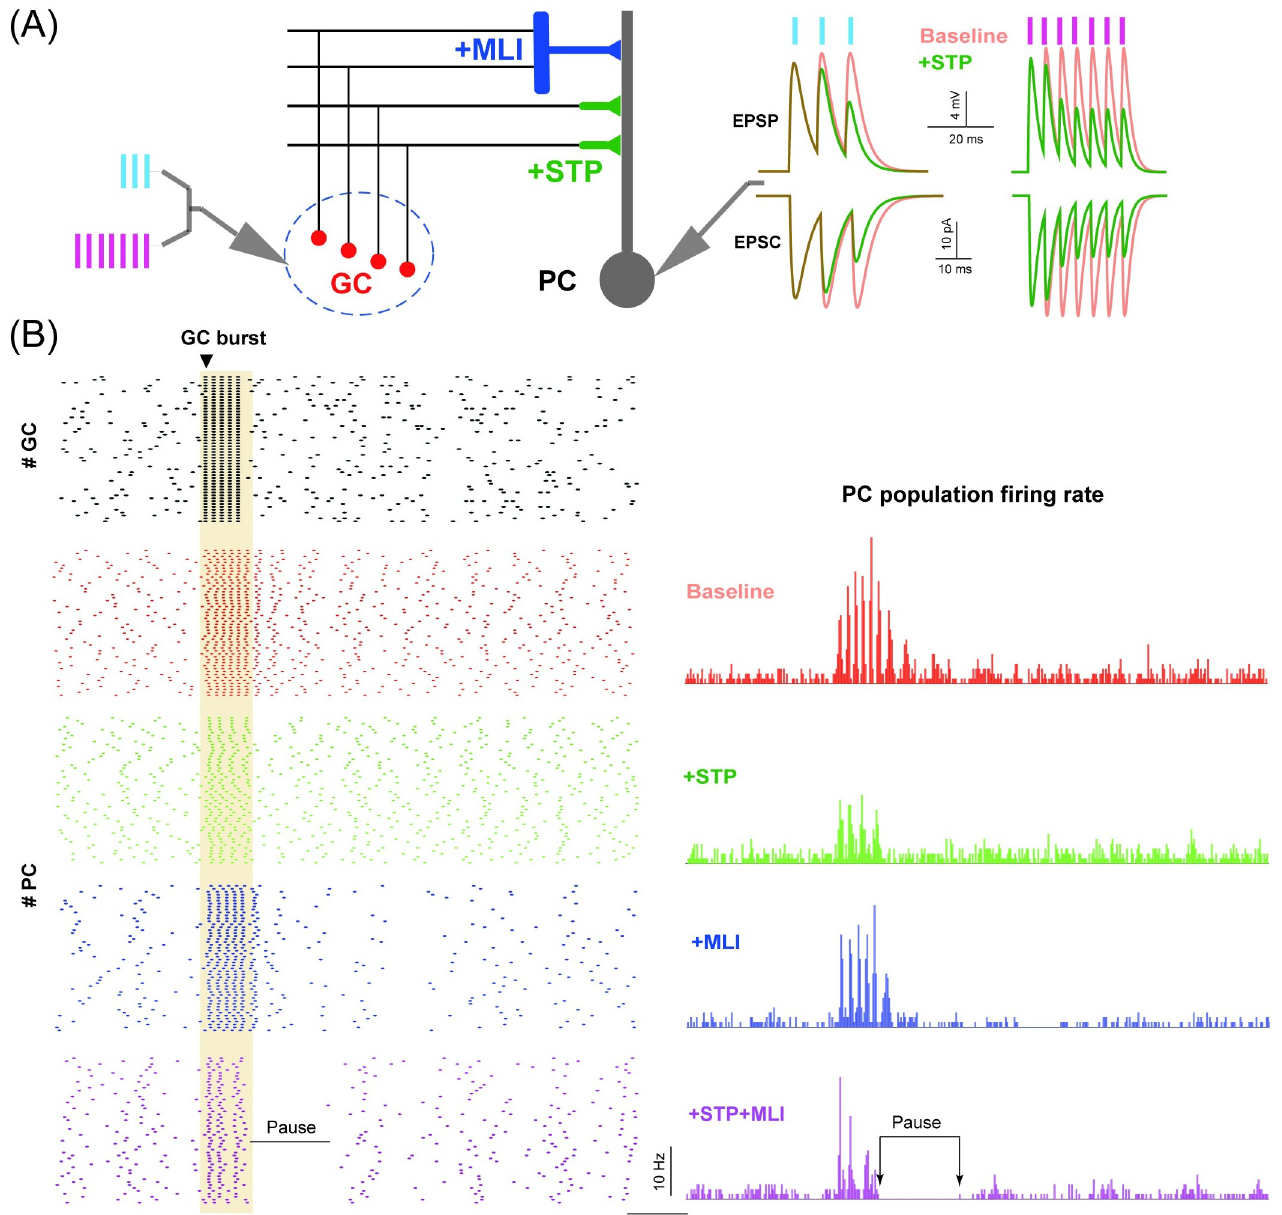
Fig 7. PC network dynamics in response to burst input. (A) Schematic illustration of GC-PC and GC-MLI-PC pathways receiving burst inputs. (Left) GCs stimulated by bursts with 3 and 7 spikes at 100 Hz. (Right) EPSPs and EPSCs recorded from PCs for different burst inputs in the baseline condition (red) and with STP on (green). (B) GC spike raster triggered by a burst input of 5 spikes at 200 Hz, only 50 GCs are shown (top). (Bottom) The corresponding spike rasters of 50 PCs (left), and averaged PC population firing profiles in different conditions. Note that the pause response indicated as the time interval between two arrows in the condition of +STP+MLI